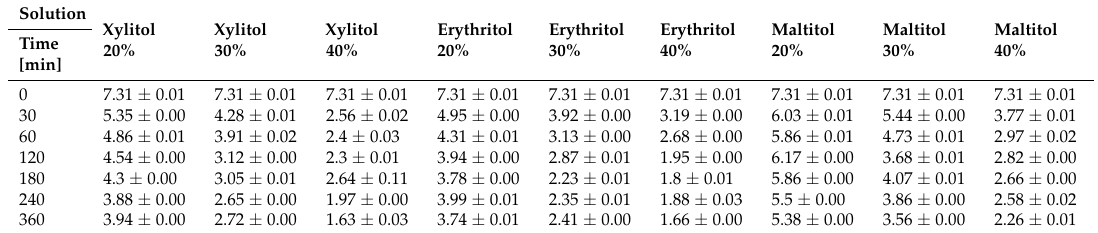
Table 1. Water content (g/g d.m.) in apples during osmotic dehydration (OD) in different solutions. Solution Xylitol